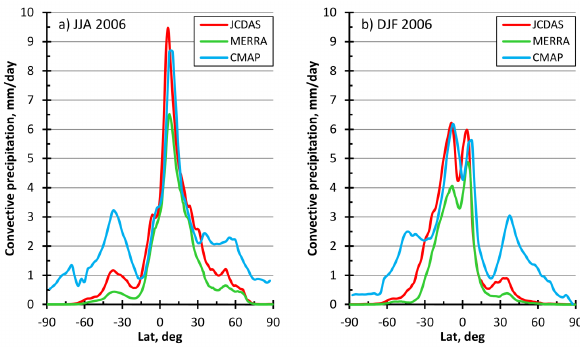
Figure 1. Zonal mean convective precipitation from the JRA-25/JCDAS, MERRA and CMAP 943 Fig. 1. Zonal mean convective precipitation from the JRA- total precipitation (mm d –1 ) averaged over (a) JJA and (b) DJF 2006. 944 25/JCDAS, MERRA and CMAP total precipitation (mm d − 1 ) av- 945 eraged over (a) JJA and (b) DJF 2006.